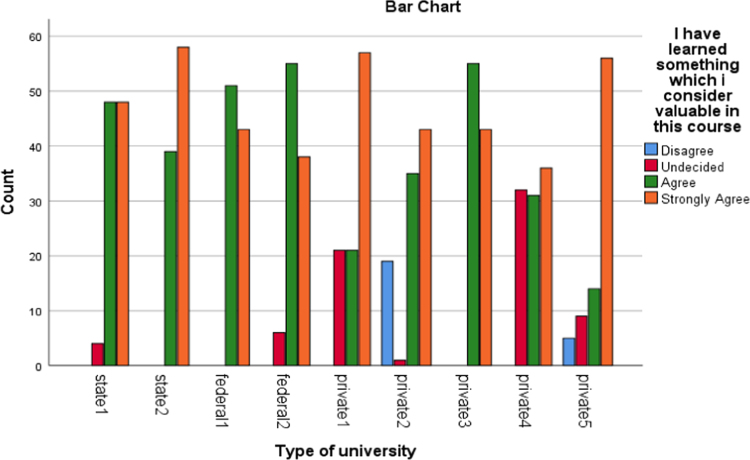
Learning Quality.